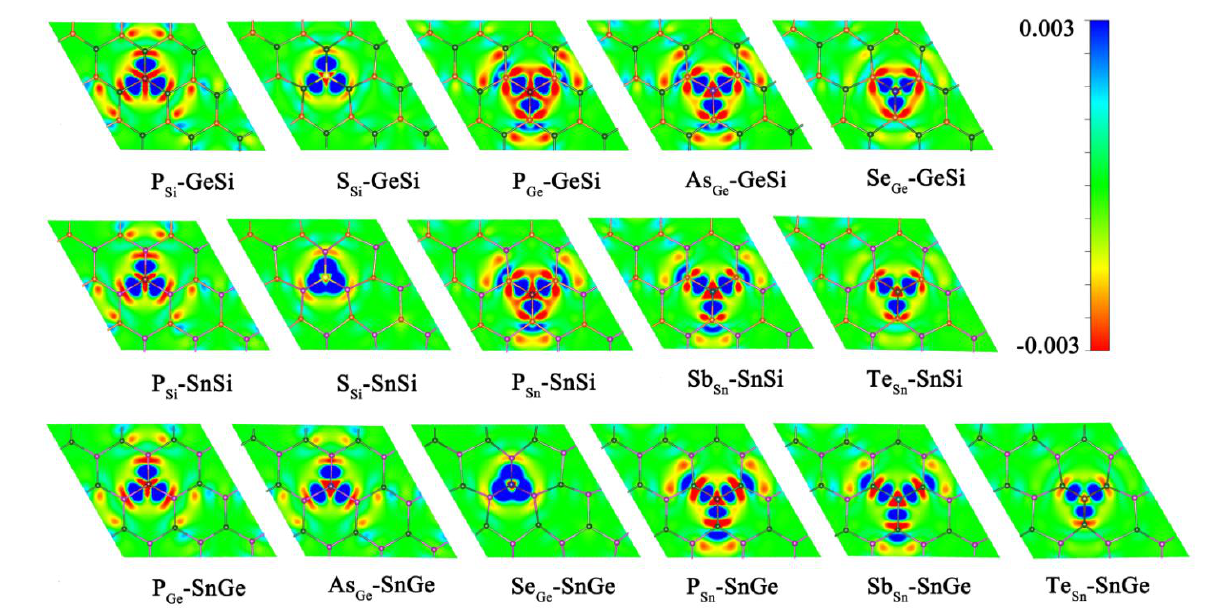
Figure 6. The charge density difference Δρ values for the doped GeSi, SnSi, and SnGe systems with the red and blue areas meaning low and high electron densities, respectively.